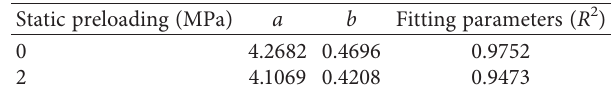
Table 3: Fitting parameters between dynamic splitting tensile strength of the limestone disk specimen and average strain